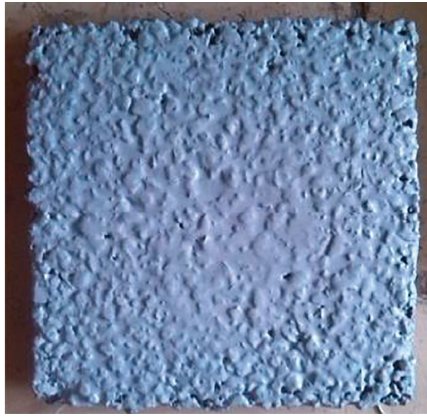
Figure 2: Photo of the reflective